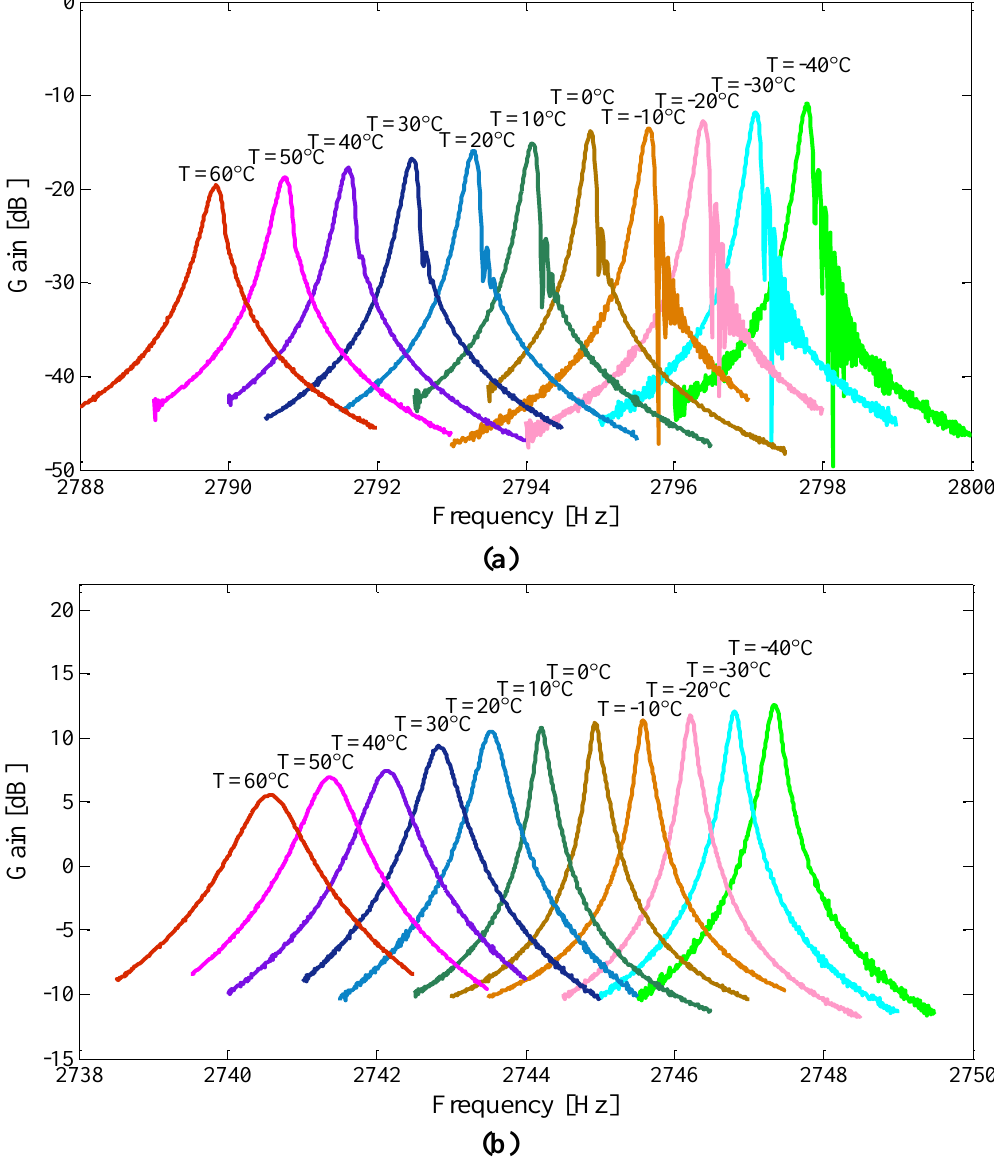
Figure 9. The frequency response characteristics of the gyroscope suspended with a C-F beam at different temperature levels, when operating at the same input conditions. (a) drive mode (b) sense